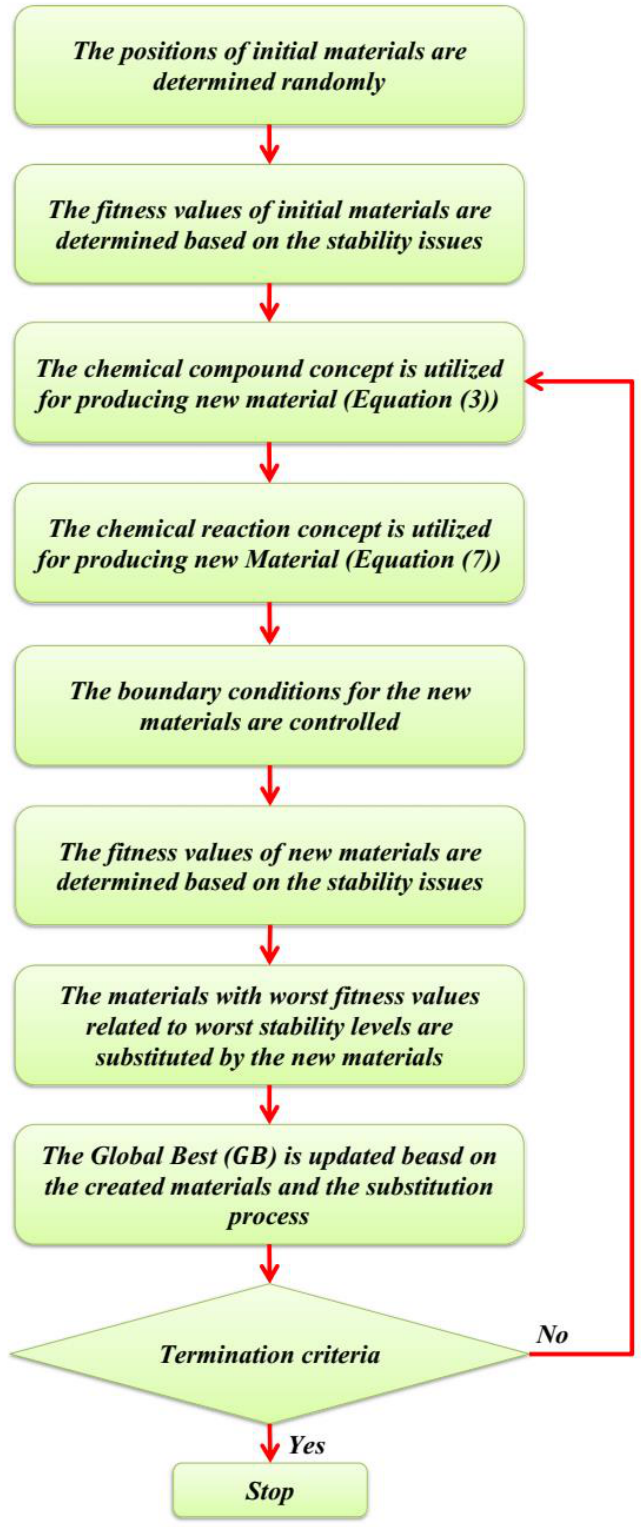
Figure 6. Flowchart of the Material Generation Algorithm (MGA).